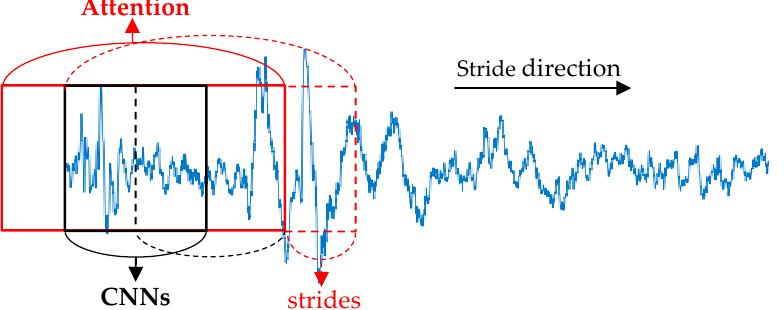
Figure 2. The CNN and attention branches perform feature extraction on the 30-s EEG epoch. The red solid line indicates the input sequence length of attention branch. The black solid line indicates the input sequence length of CNN branch. The dotted line indicates where the two branches will slide forward next.